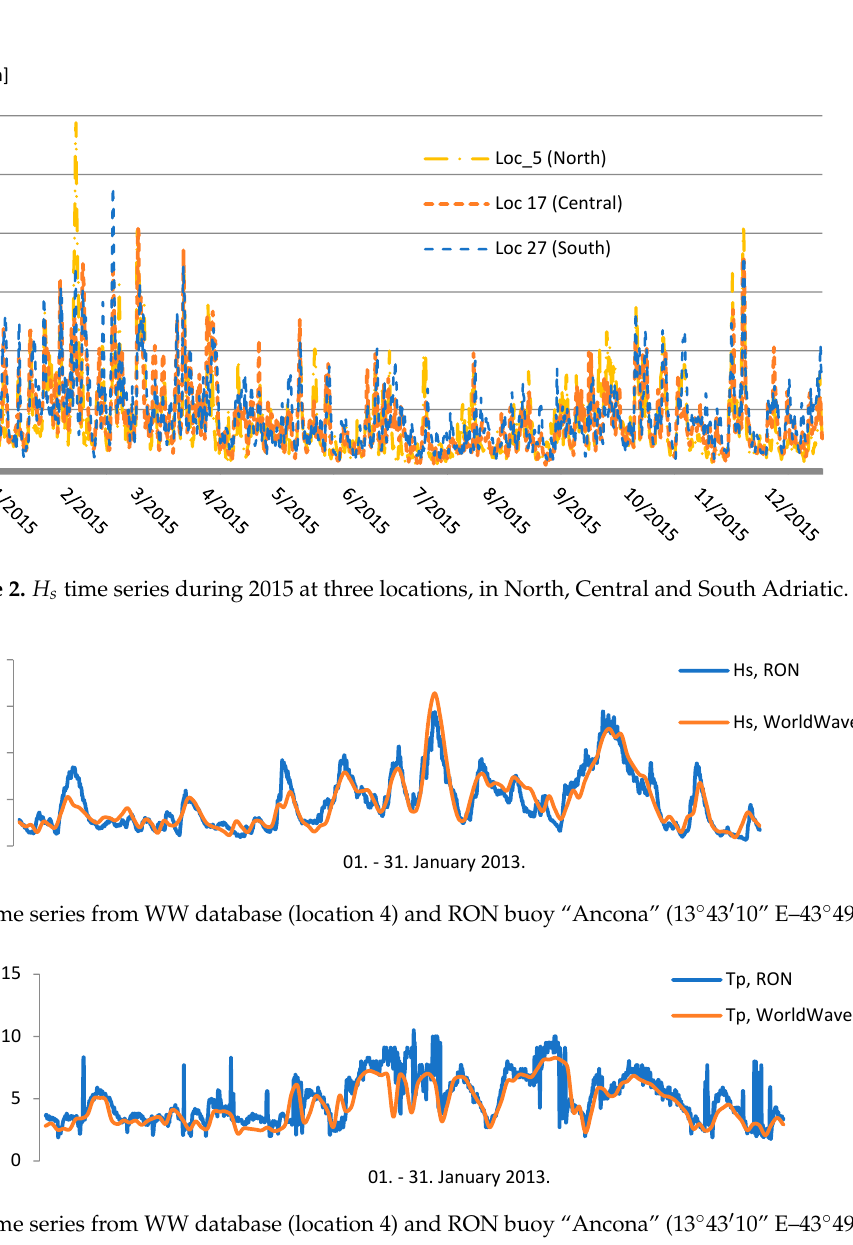
Figure 4. Tp time series from WW database (location 4) and RON buoy “Ancona” (13°43 ′ 10 ″ E–43°49 ′ 26 ″ N) .